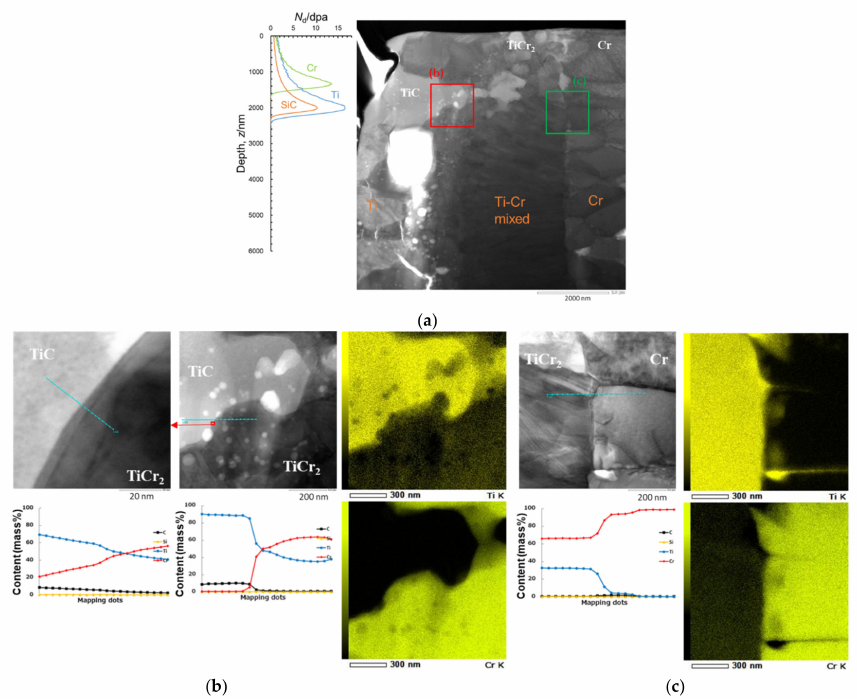
Figure 12. EDS line profiles and mappings of chemical composition across phase interfaces in Ti-Cr multilayer coating after being irradiated with Si 2+ ions up to a fluence of 2.85 × 10 20 ions /m 2 . ( a ) Overview of the analyzed areas. ( b , c ) Analyzed areas described in ( a ). In ( b ) the TiC/ TiCr 2 phase interface was included and in ( c ) the TiCr 2 /Cr phase interface was